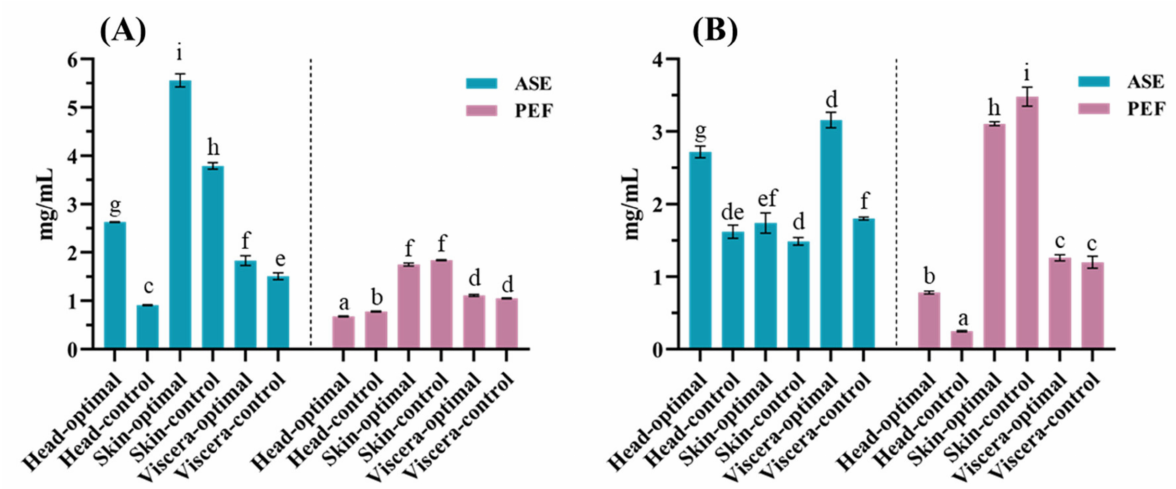
Figure 1. Protein content in the control and optimal PEF/ASE assisted extracts from fish by-products. ( A ) rainbow trout and ( B ) sole; PEF: pulsed electric fields; ASE: accelerated solvent extraction; Different lowercase letters (a–i) in the figure indicate statistically significant differences ( p <